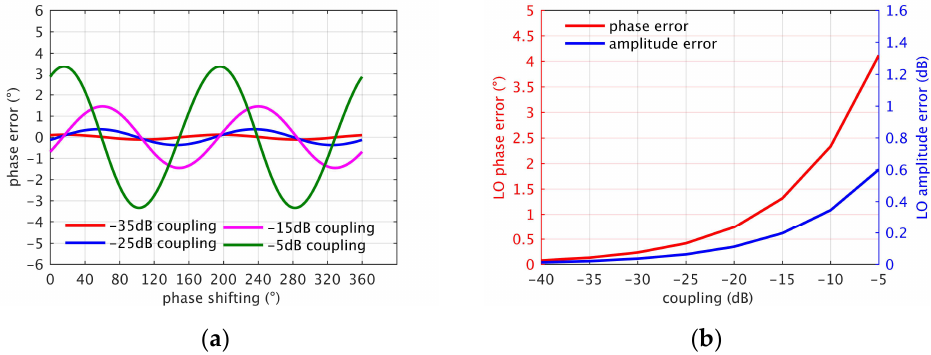
Figure 8. ( a ) Adjacent coupling channel’s influence on phase error related to phase shift; ( b ) statistics of influence on amplitude and phase of adjacent channels during phase shift.